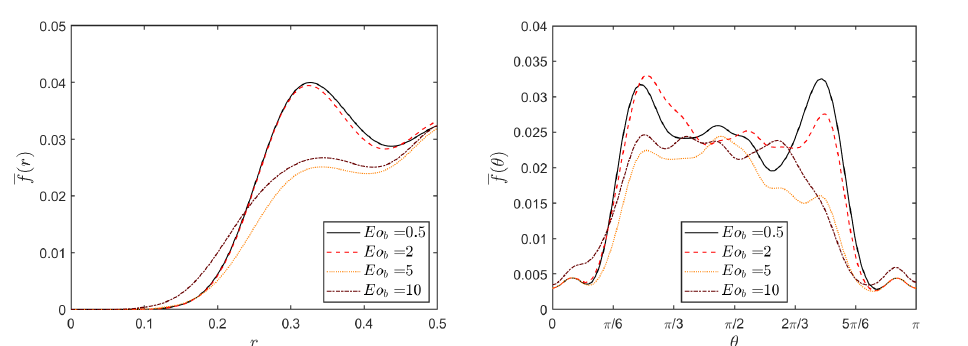
Figure 6. The angular average distribution function versus distance from the bubble center ( left ) and radially average distribution function versus angle, measured from the top of the bubble ( right ).